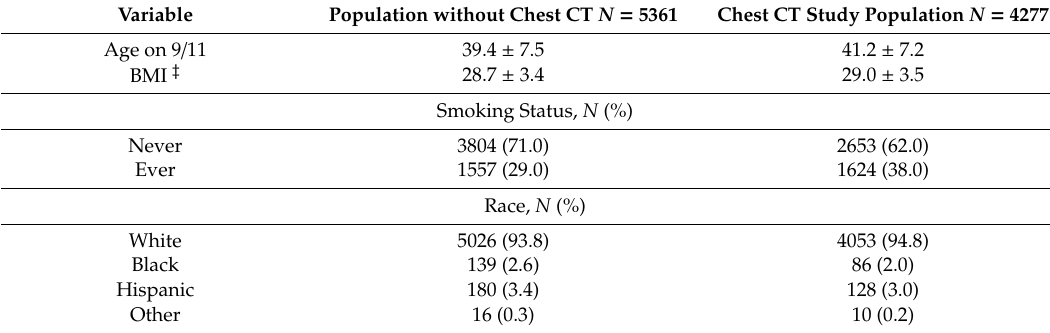
Table 1. Population characteristics